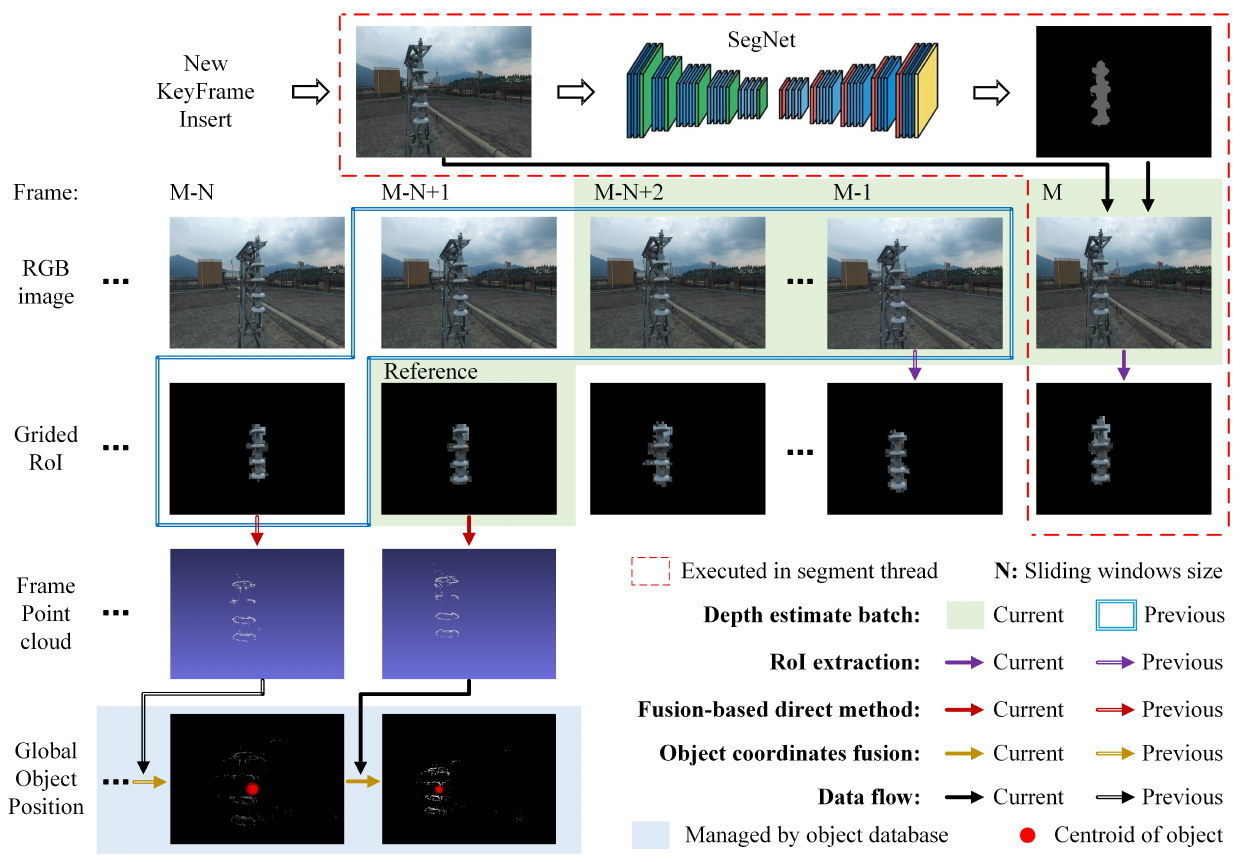
Figure 4. The visualization flowchart of semantic object